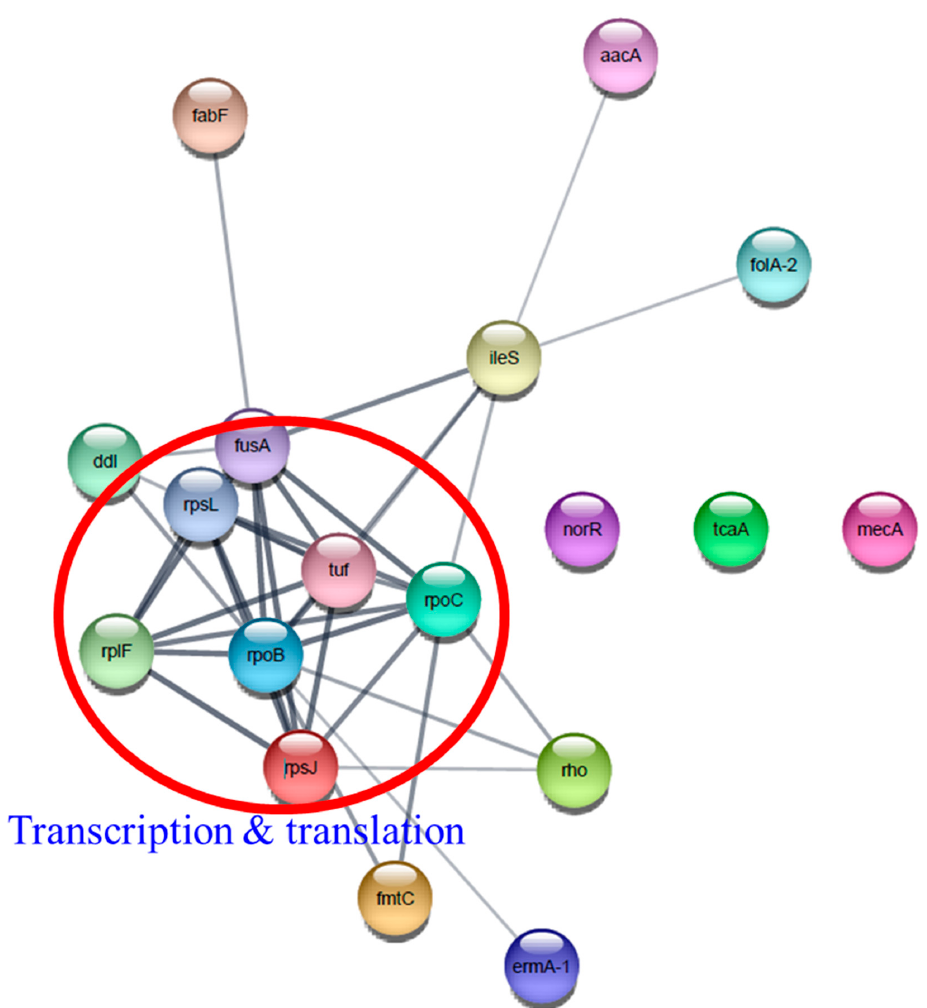
Figure 13. Protein–protein interaction network analysis of differentially expressed proteins associated with antibiotic resistance using STRING database and Cytoscape. Transcription and translation proteins were indicated by a red circle.